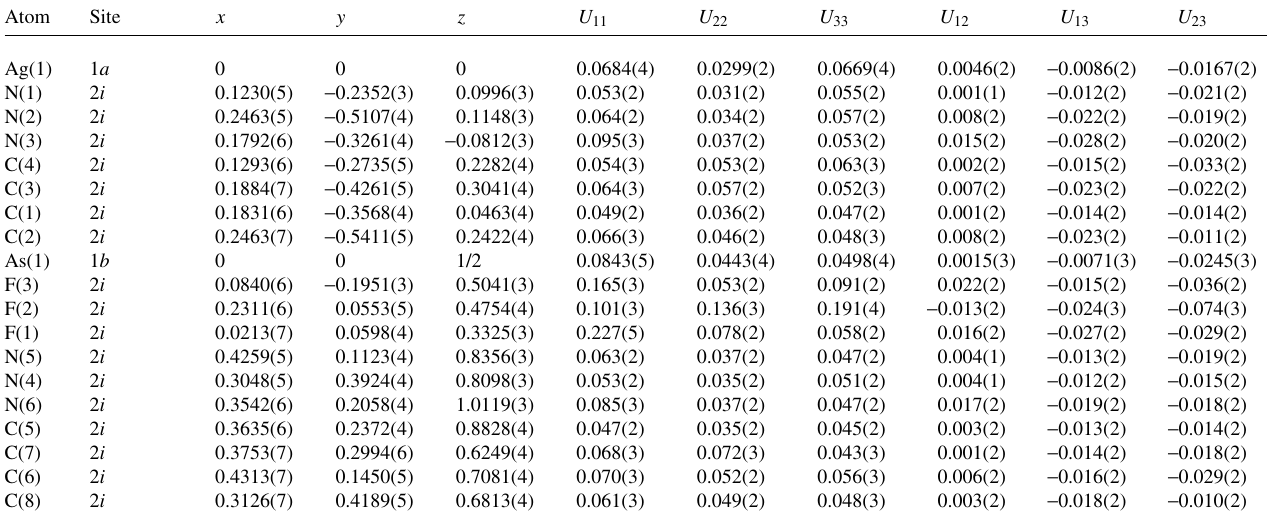
Table 3. Atomic coordinates and displacement parameters (in Å 2 )